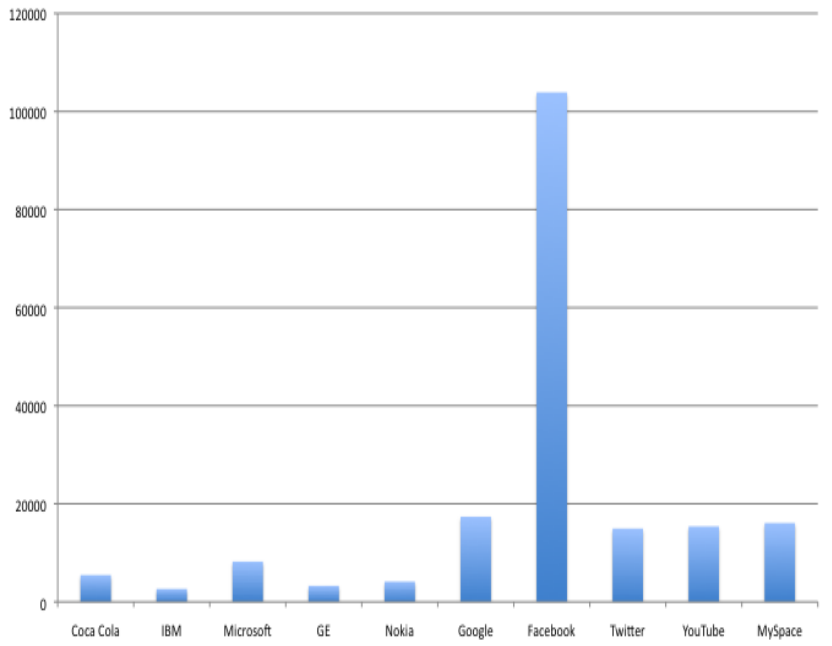
Figure 1: An illustration of brand visibility scores – Most valuable brands and well-known social media brands The study and methodology